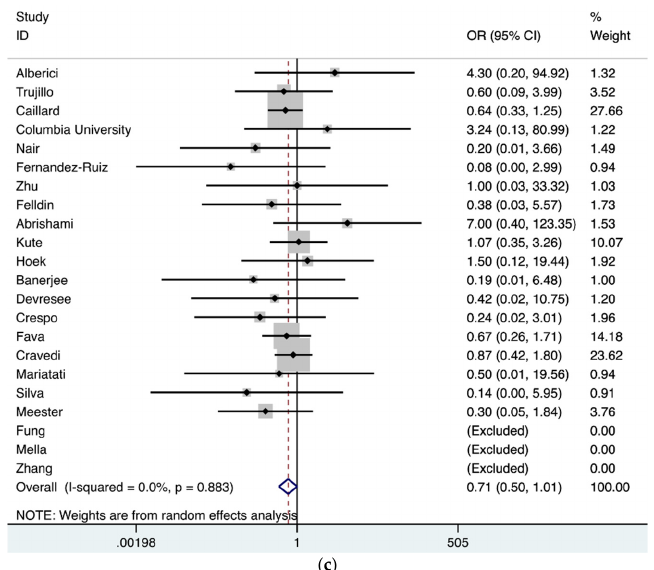
Figure 5. ( a ) Forest plot depicting COVID-19 associated mortality risk in kidney transplant recipients. The diamond shows higher risk in patient group ≥ 60 years of age, OR= 3.90 (red dashed line). The edges of the blue diamond represent 95% confidence intervals (2.56–5.94); ( b ) Forest plot depicting COVID-19 associated mortality risk in kidney transplant recipients in the late post-transplant period group (>2 years) in contrast to the early post-transplant period ( ≤ 2 years). The diamond shows no increased risk between the groups; OR 1.37 represented by red dashed line with the edges of the blue diamond representing 95% confidence intervals (0.72–2.58); ( c ) Forest plot depicting sex related mortality risk in COVID-19 suffering kidney transplant recipients. The diamond shows no increased risk between the groups; OR 0.71 represented by vertical red dashed line with the edges of the blue diamond representing 95% confidence intervals (0.50–1.01). OR: Odds ratio.